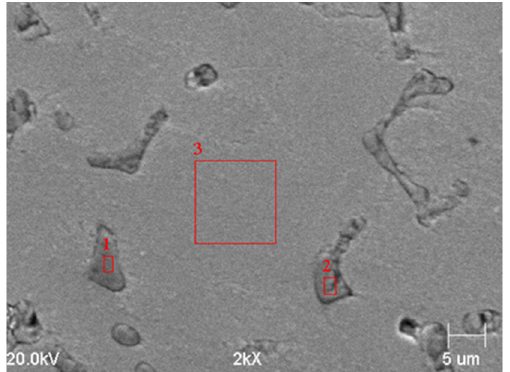
Figure 7. SEM image of an alloy containing 5.5% V after solution treatment; austenitic matrix with primary vanadium carbides; the red marks denote places of analysis. Table 4. Sample chemical compositions of the visible precipitates (Figure 7).